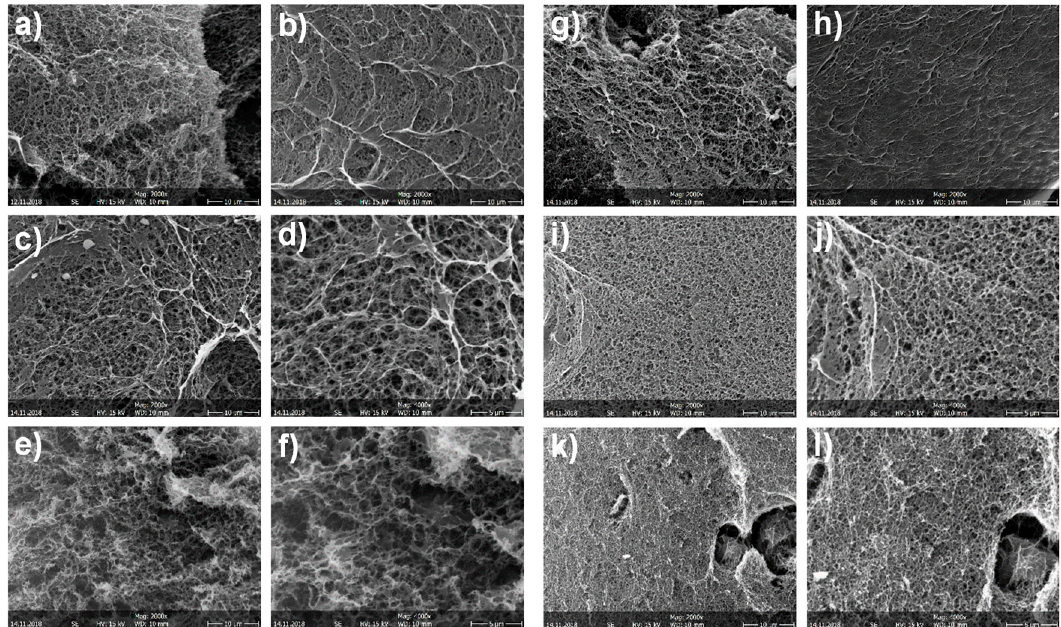
Figure 5. Scanning electron micrographs of scaffolds obtained after freeze-drying of CNF/CHI composite hydrogels containing ( a – f ) 2% and ( g – l ) 3% ( w / w ) chitosan. ( a , b ) neat 2% CHI; ( c , d ) 2% CHI/0.2% CNF; ( e , f ) 2% CHI/0.4% CNF; ( g , h ) neat 3% CHI; ( i , j ) 3% CHI/0.2% CNF; ( k , l ) 3% CHI/0.4%